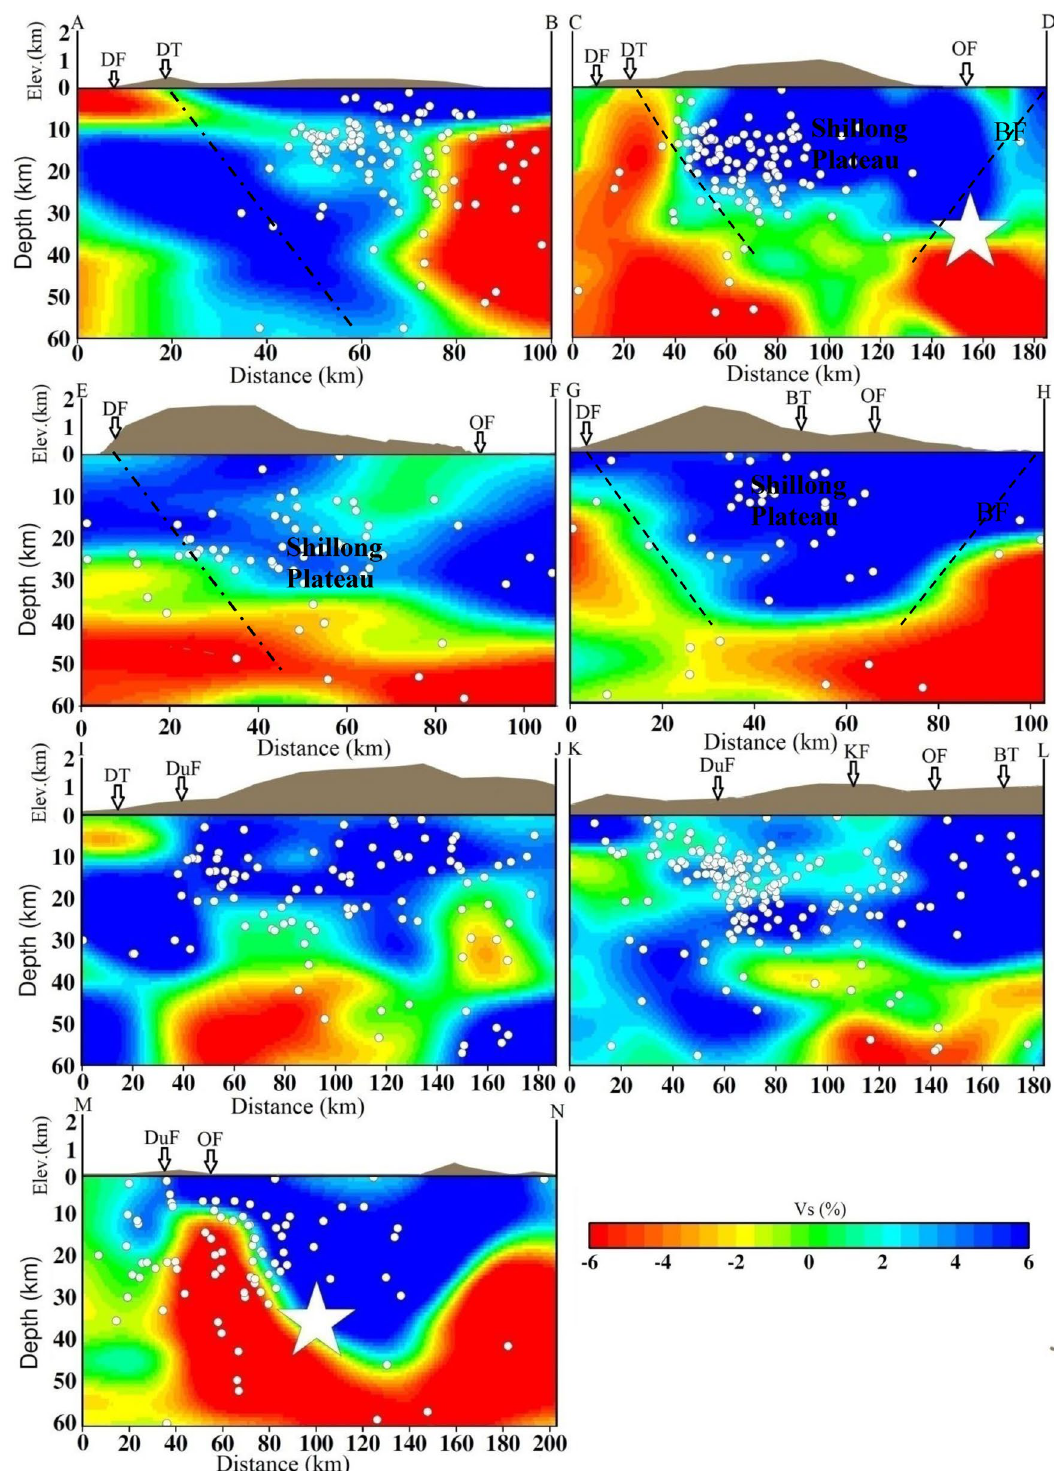
Figure 3. Vertical cross sections of the S- wave velocity models. The positions of cross sections are shown in Fig. 1. The star shows the 1897 Shillong earthquake (M s 8.7). The geological faults are also